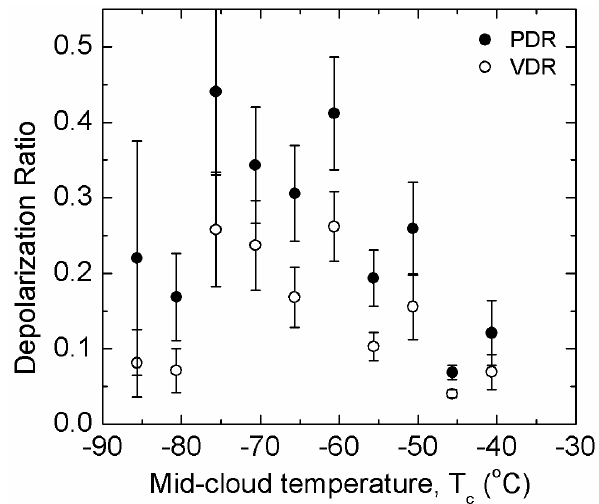
Fig. 13. Temperature dependence of volume depolarization ra- tio (VDR) and particulate depolarization ratio (PDR). Open circles present the averaged values of VDR and filled circles present the averaged values of PDR grouped at 5 ◦ C interval. The vertical bars indicate the associated standard